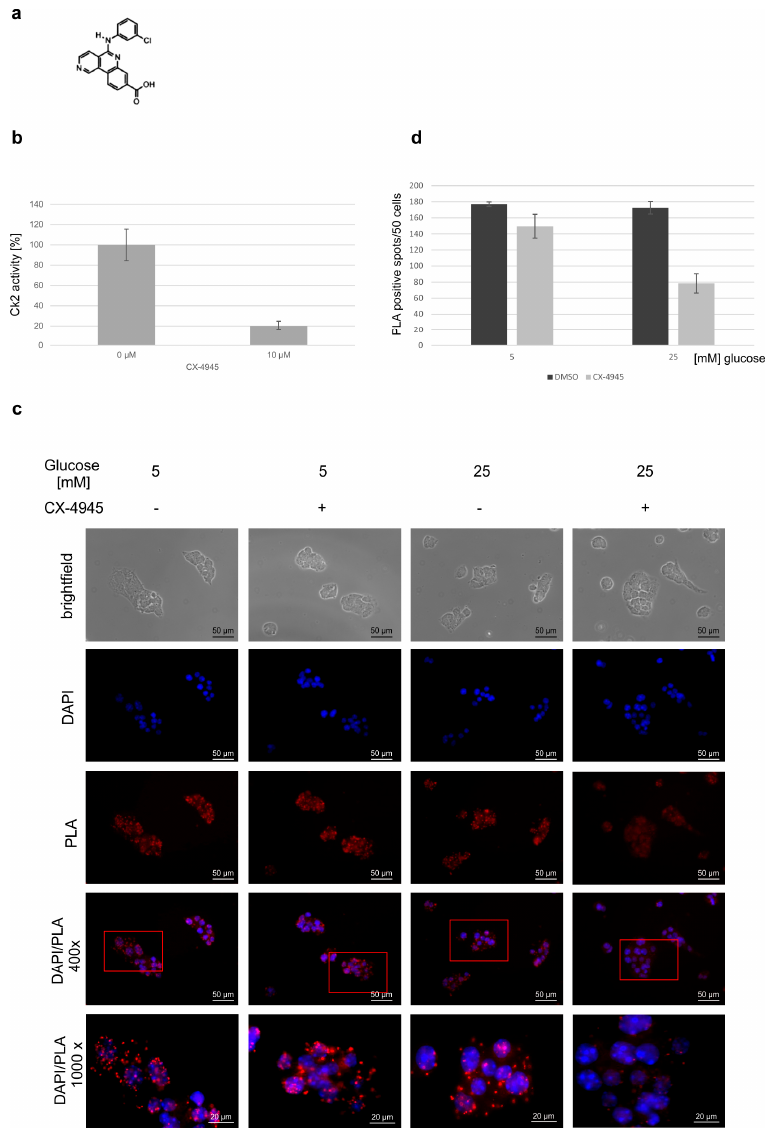
Figure 2. Influence of glucose and CK2 inhibitor CX-4945 on the interaction of PDX-1 and PCIF1. ( a ) Chemical structure of CX-4945 (Silmitasertib); ( b ) in vitro phosphorylation assay in the absence and presence of CX-4945. MIN6 were treated with DMSO as control (0 µ M) or with 10 µ M CX-4945 for 24 h. Kinase activity of CK2 in the cell extracts was measured with the synthetic CK2 specific peptide substrate, RRRDDDSDDD, in the presence of [ 32 P] γ ATP. Results from three individual experiments are shown; the activity in the control cells was set to 100%; ( c ) Duolink ® in situ proximity ligation assay (PLA) of PDX-1 and PCIF1 in MIN6 cells. MIN6 cells were incubated with 5 mM or 25 mM glucose for 4 h after 5 h starvation and simultaneously with 10 µ M CX-4945 (+) or an equal volume DMSO for control ( − ). Cells were subjected to Duolink ® in situ proximity ligation assay using antibodies against PDX-1 (polyclonal rabbit antiserum) and PCIF1 (mouse monoclonal antibody SPOP B-8). Immunofluorescence was analyzed using a Zeiss Axioskop fluorescence microscope (Zeiss, Jena, Germany); and ( d ) quantification of the interaction. Single dots were counted in 50 cells of three different areas. Experiments in the absence of CX-4945 were used as reference (100%). The bar graph shows the median results of three independent